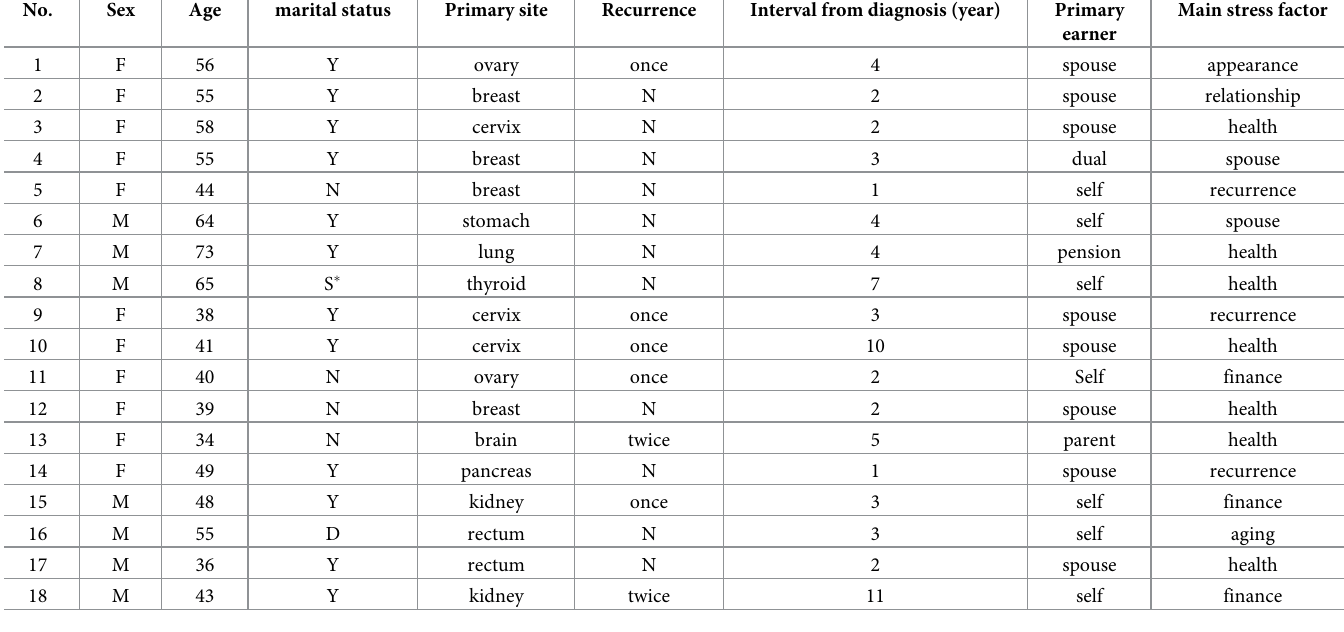
Table 1. Participants’